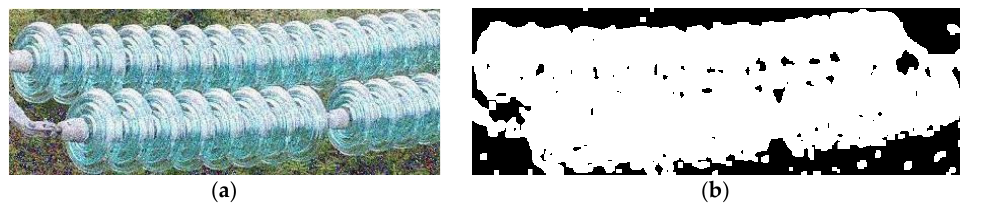
Figure 14. Detection failure analysis: ( a ) insulator image with Gaussian noise; ( b ) image segmenta-